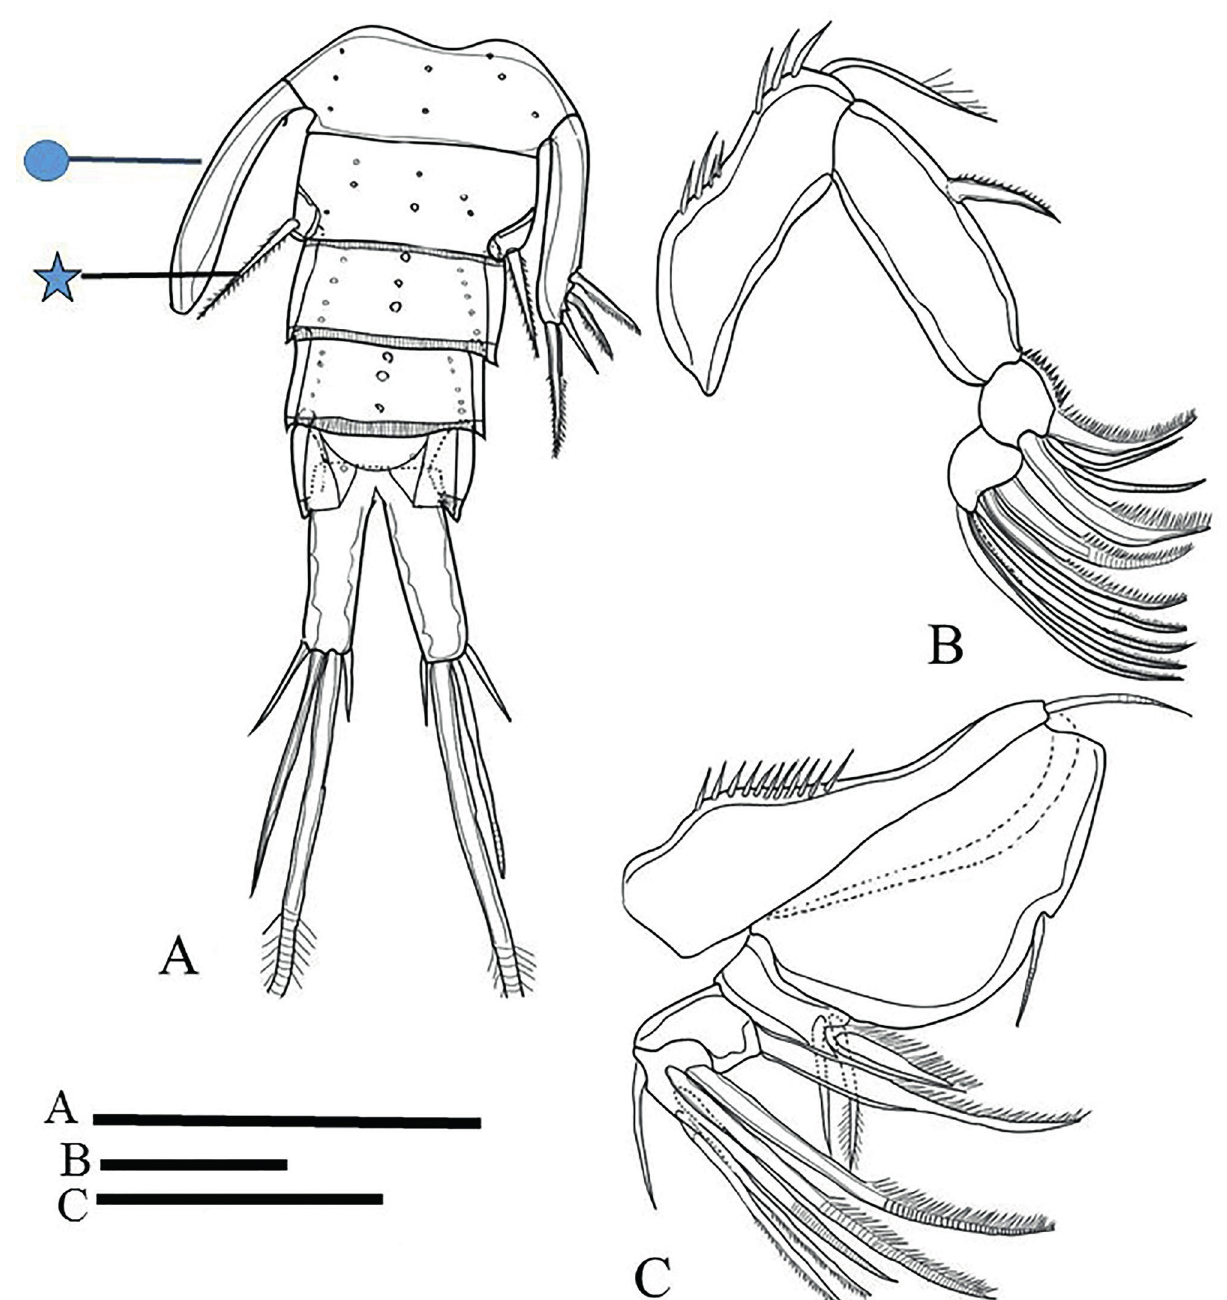
Figure 7. Clausidium persiaensis sp. nov. A, urosome (male); B, antenna (male); C, antenna (female). Circle = P5 (male); star = P6 (male). Scale bars: A, 100 μm; B, 50